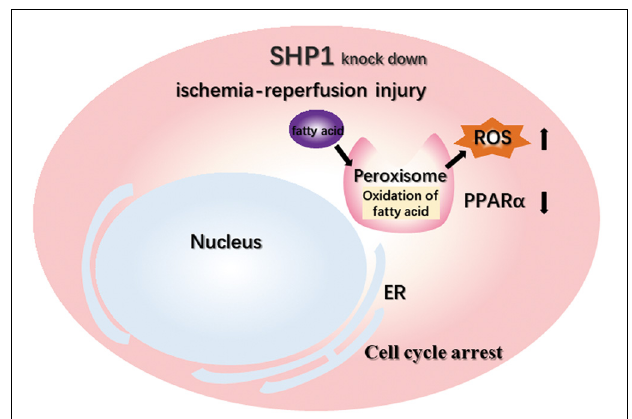
FIGURE 5 | Schematic of the mechanisms that aggravate IRI after SHP-1 knockdown, possibly through downregulation of the PPAR α signaling